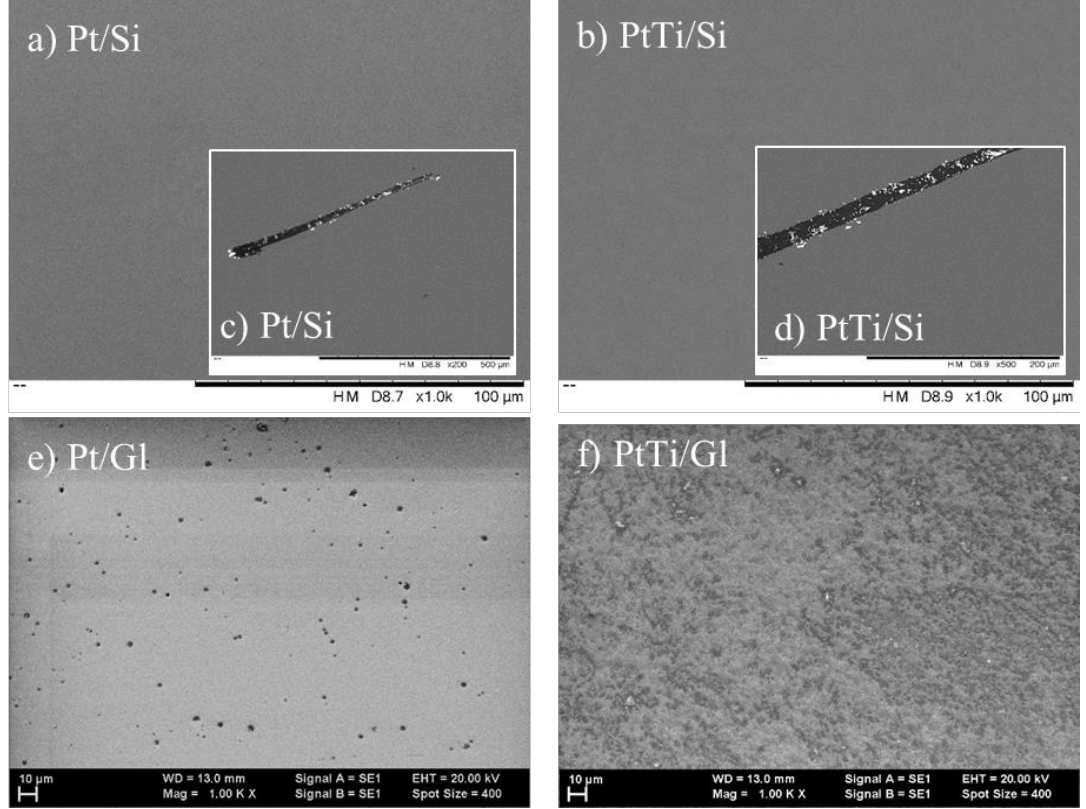
Figure 1. SEM images of: ( a ) Pt/Si and ( b ) PtTi/Si thin films deposited on Si substrate at an acceleration voltage of 15 kV and magnifications of: 1000×, and SEM images after the scratch for the determination of adhesion test: ( c ) Pt/Si and ( d ) PtTi/Si film. Images ( e ) and ( f ) present Pt/Gl and PtTi/Gl thin films deposited on a glass substrate.